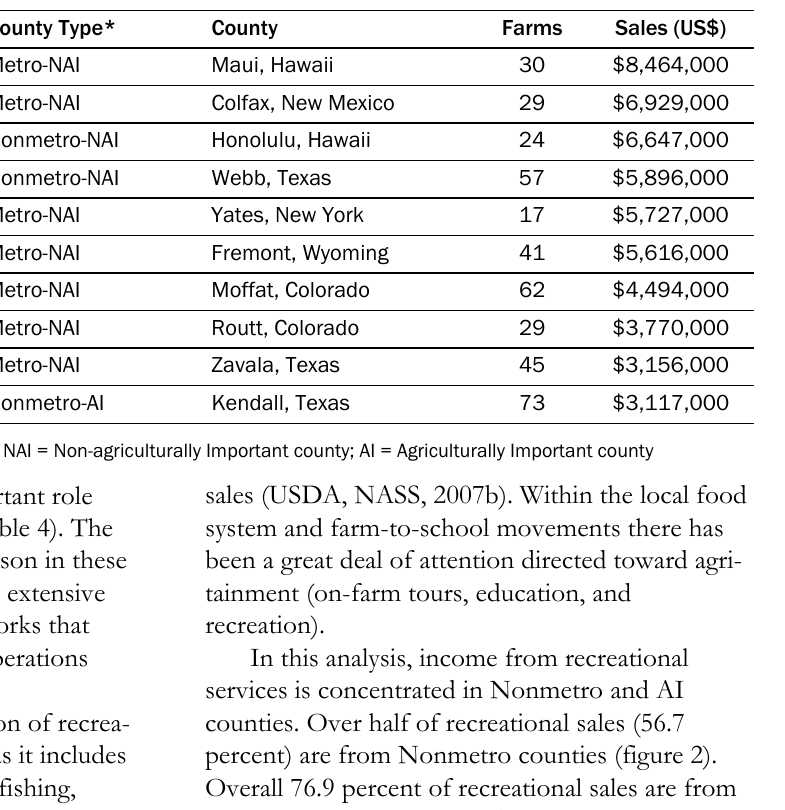
Table 5. Top 10 Recreation Counties by Sales, 2007